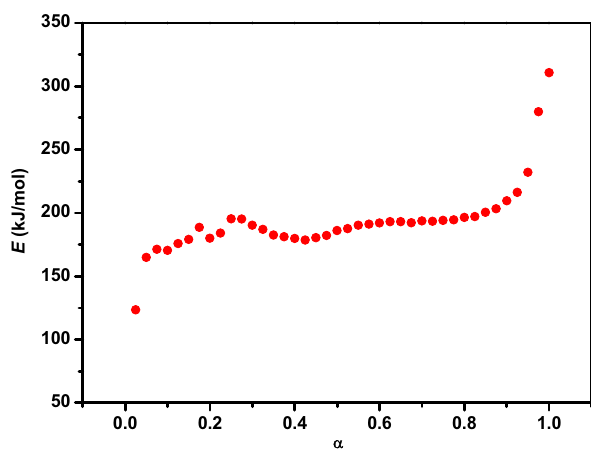
Figure 4: E – a curve of polyacrylate PSA during thermal decomposition.